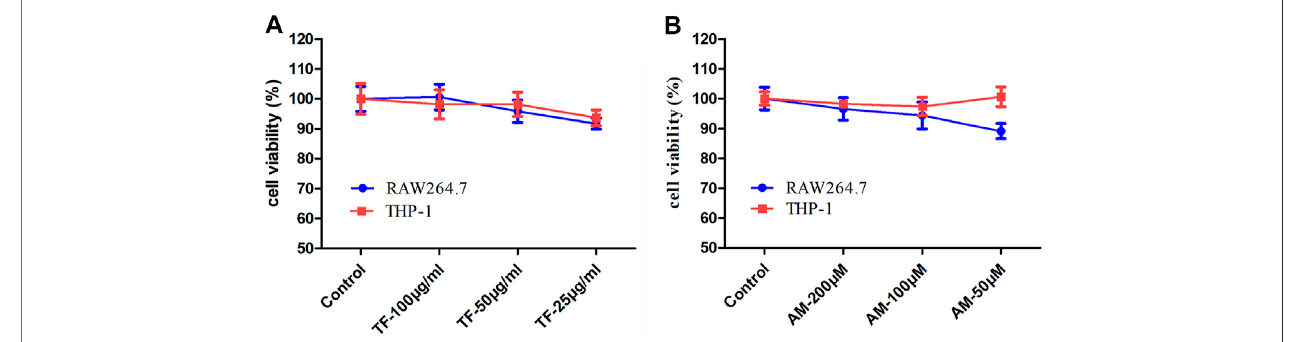
FIGURE4| TheeffectsofTFandAMonin fl ammatorycytokine (A) ThelevelofNOintheRAW264.7cells (B) ThelevelofIL-1 β intheRAW264.7cells (C) Thelevelof IL-1 β in the THP-1 cells (D) The level of TNF- α in the THP-1 cells. * p < 0.05 and ** p < 0.01, signi fi cantly different the normal control group; # p < 0.05 and ## p < 0.01, signi fi cantly different the LPS/MSU control group. TF, fl avonoid extract; AM, amento fl avone.